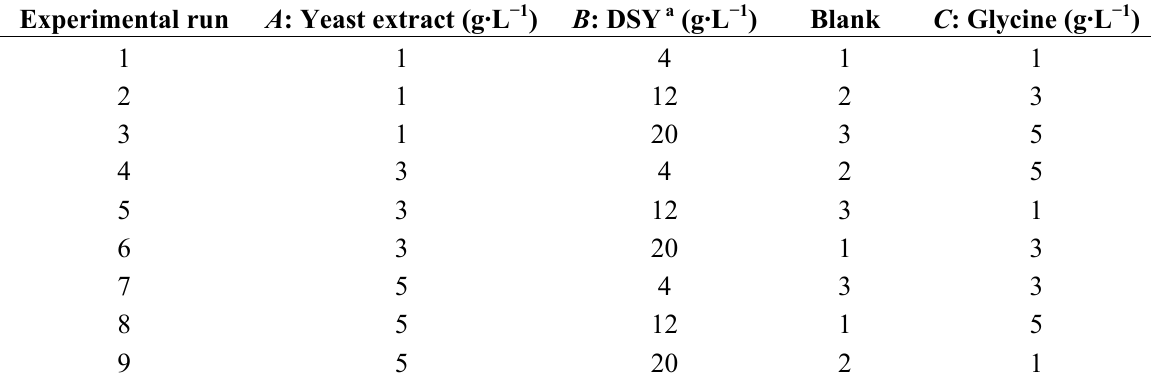
(3 4 ) orthogonal design for the ethanol Table 1. The L 9